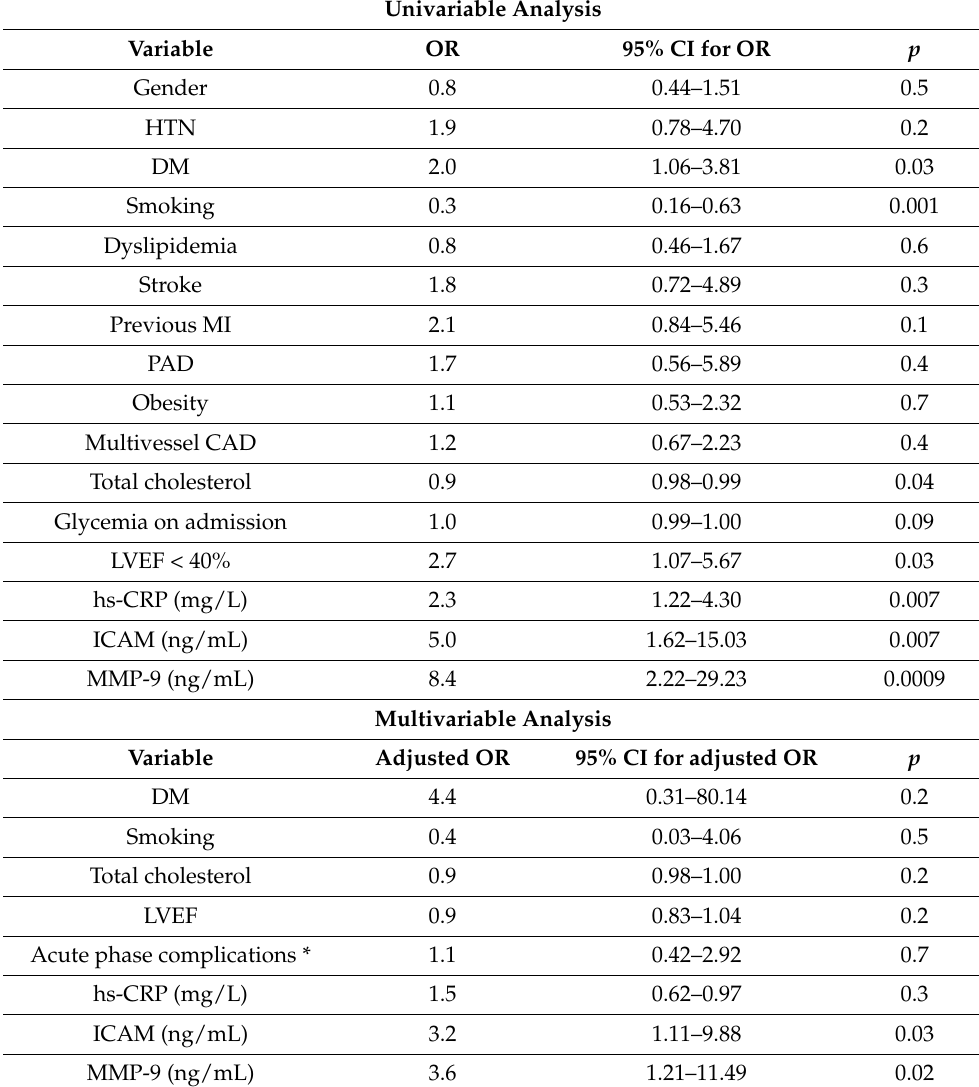
Table 5. Uni- and multivariable logistic analysis for predictors of MACE during the 1 year